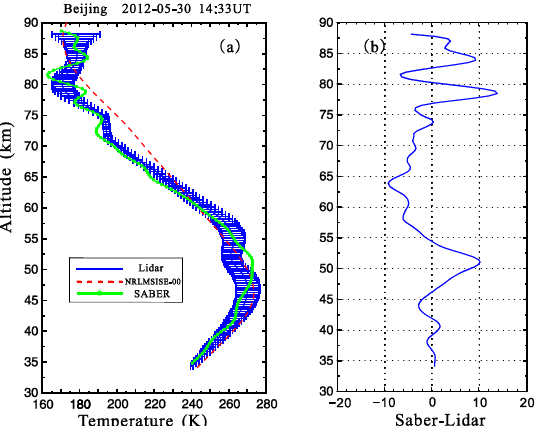
Figure 8. Temperature measurement comparison. ( a ) Temperature profiles measured by lidar and TIMED/SABER over Beijing at 1433 UT on 30 May 2012. The red dashed line indicates the temperature profile from the NRLMSISE-00 model. The horizontal bars represent standard deviations of the lidar-measured temperature. ( b ) Temperature difference (SABER-lidar) between the lidar and TIMED/SABER measurements at different altitudes.